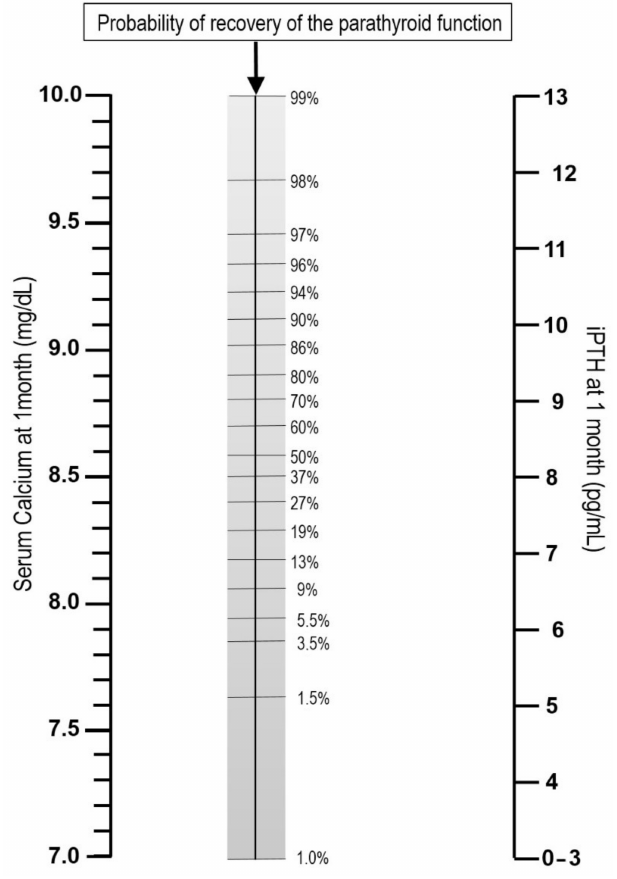
Figure 1. Nomogram to calculate the probability of recovering from protracted hypoparathyroidism based on s-Ca and iPTH (intact parathyroid hormone) measurements one month after total thyroidec- tomy (Readapted with permission from ref.